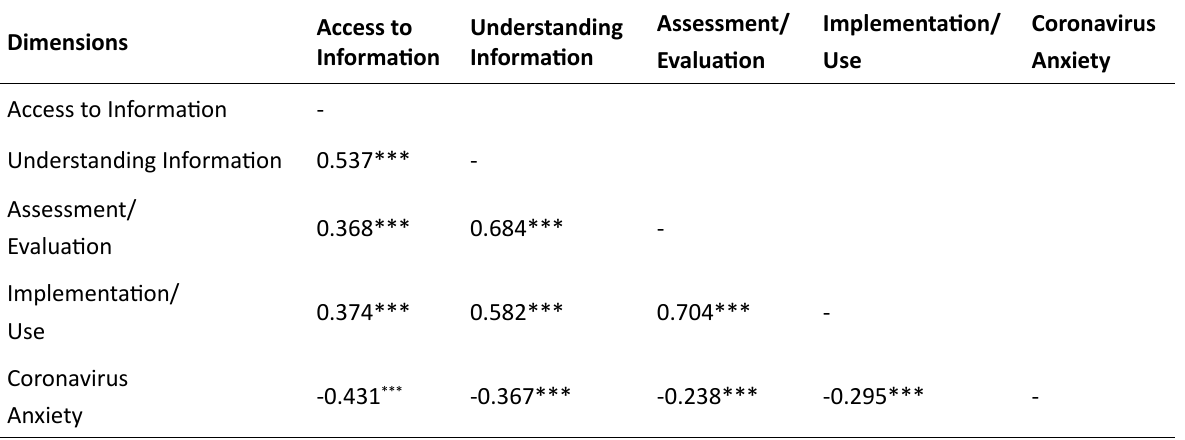
Table 2. Analysis Results of Pearson Correlation Between Health Literacy Sub-dimensions and Coronavirus Anxiety